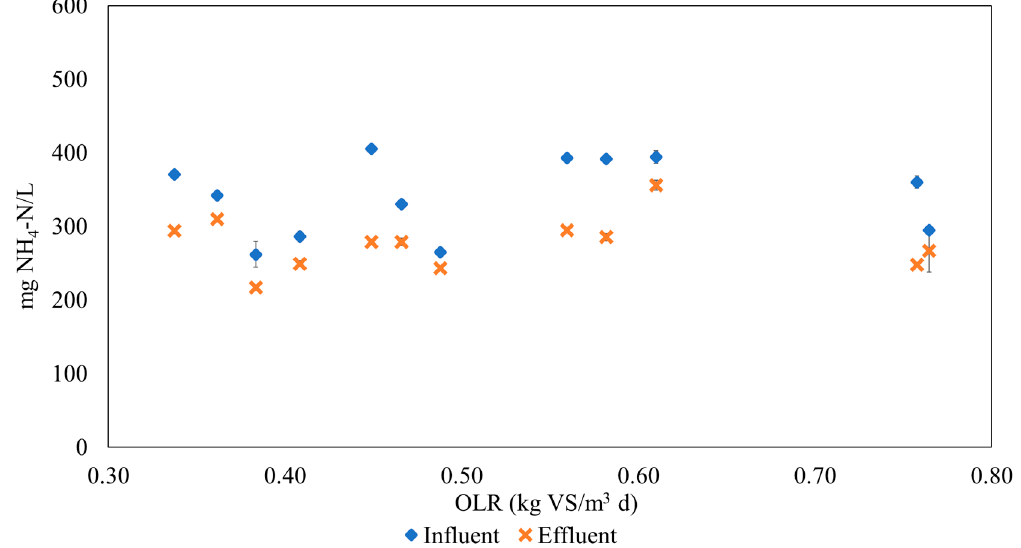
Figure 7. Ammonium changes in affluent (blue rhombus) and effluent (orange cruxes).